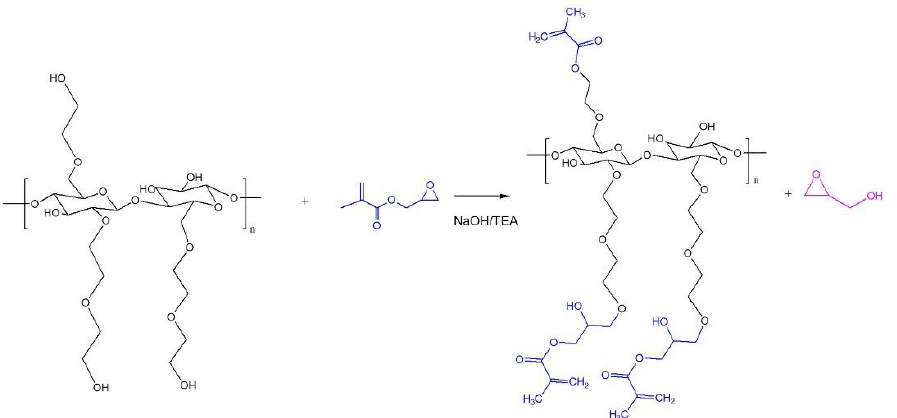
Figure 1. Proposed reaction scheme of HEC with glycidyl methacrylate at alkaline conditions (pH 13.3).